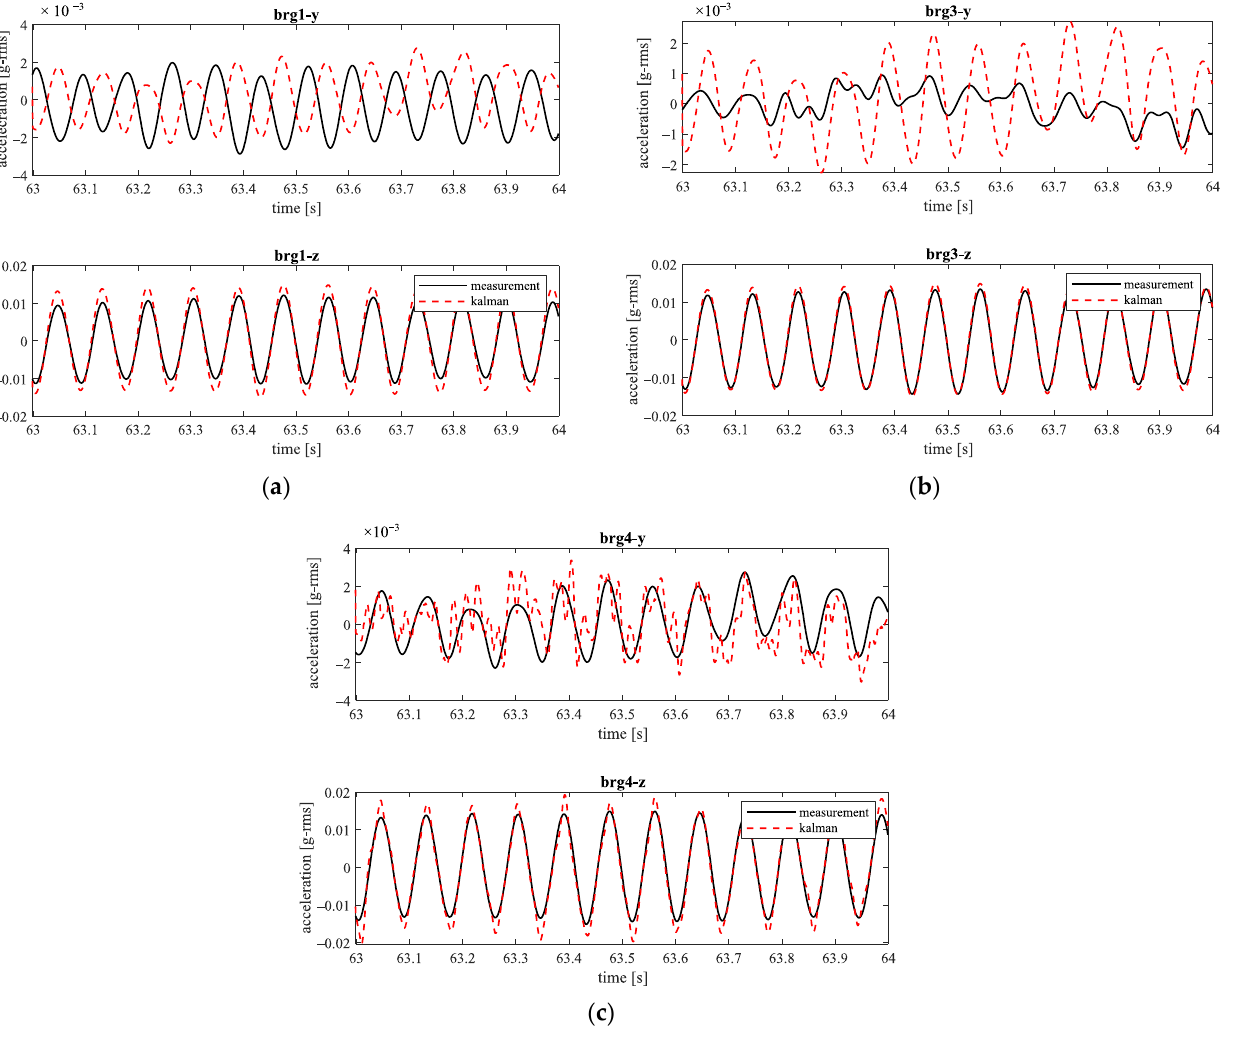
Figure 17. Kalman filter for prediction and validation, ( a ) bearing 1, ( b ) bearing 3, ( c ) bearing 4. Table 6. Configuration used for section of observation and